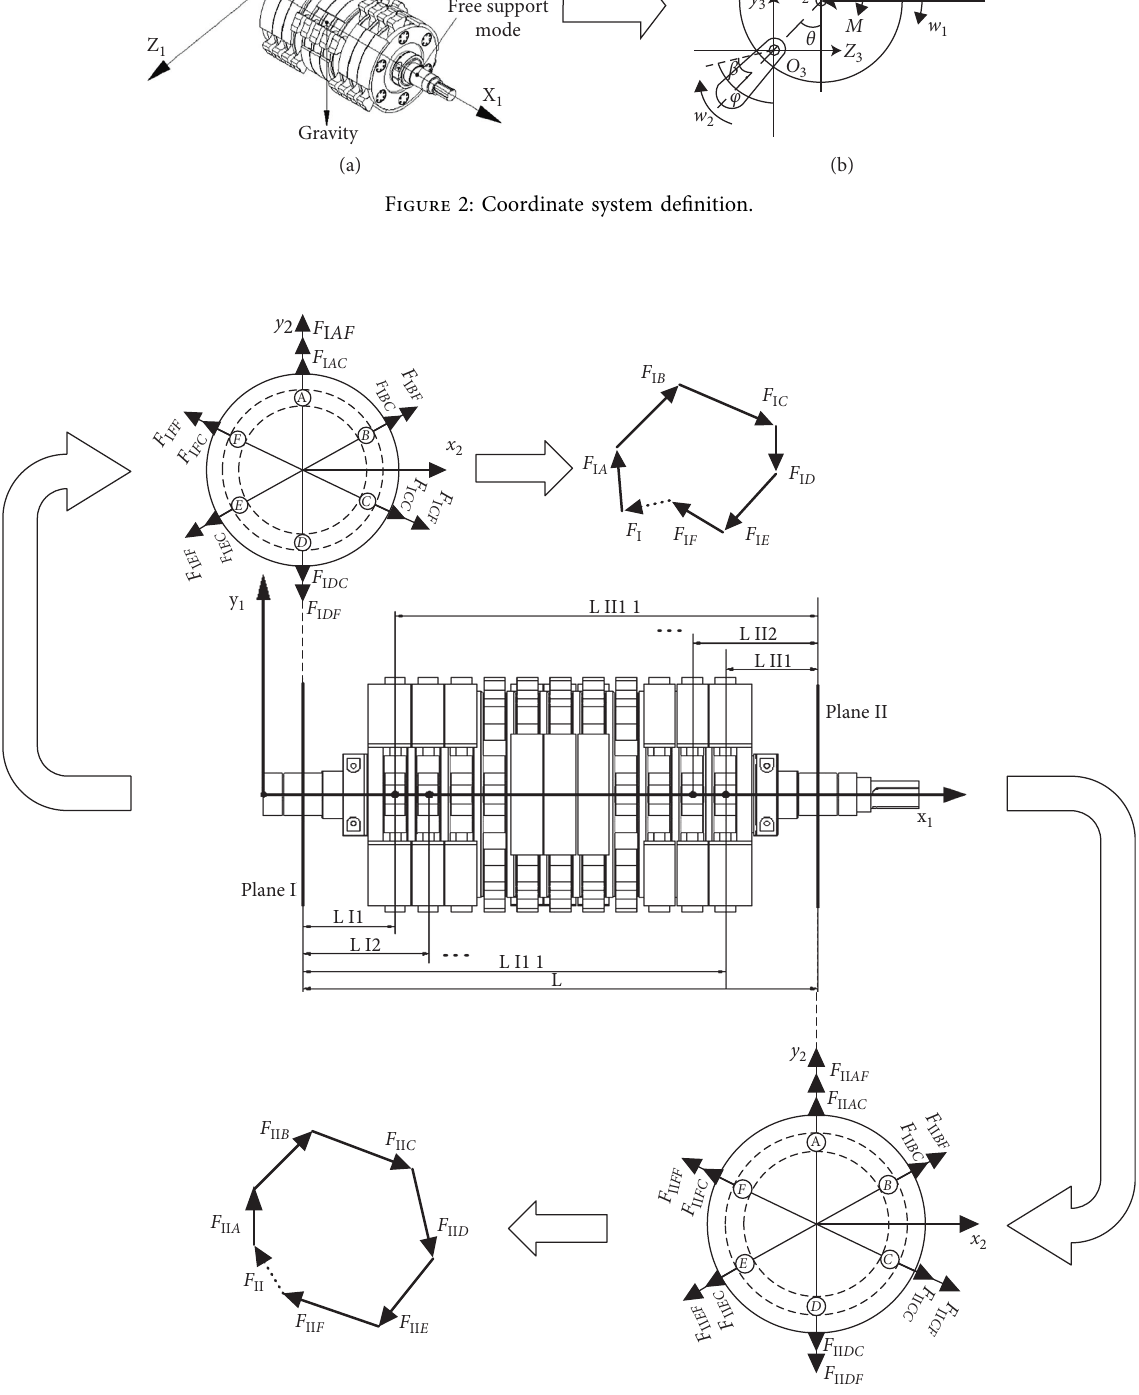
Figure 3: Decomposition of inertial force in plane Ι and plane ΙΙ